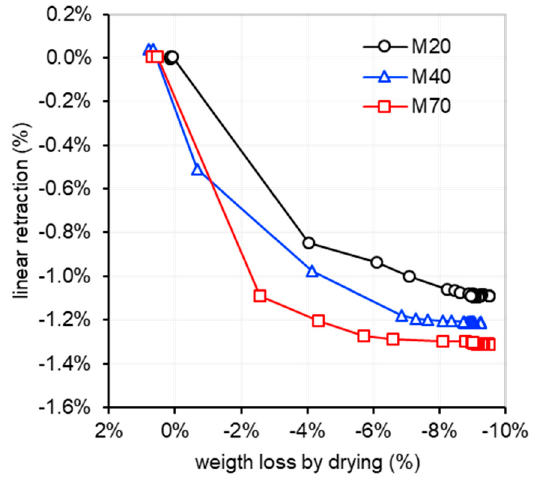
Figure 5. Shrinkage vs. weight loss for activated mortars.